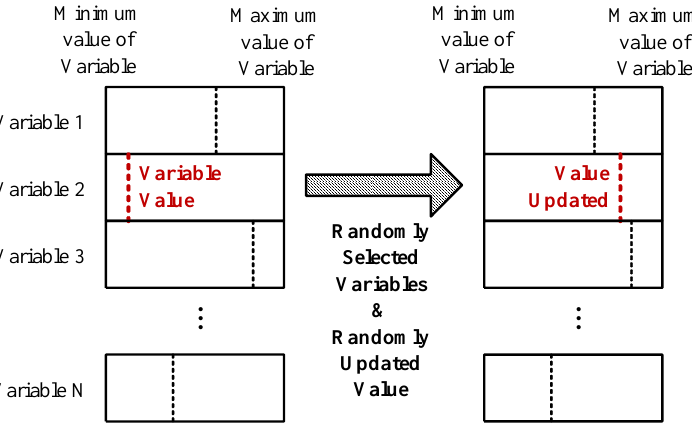
Figure 5. Variables updated by the wake-up strategy.